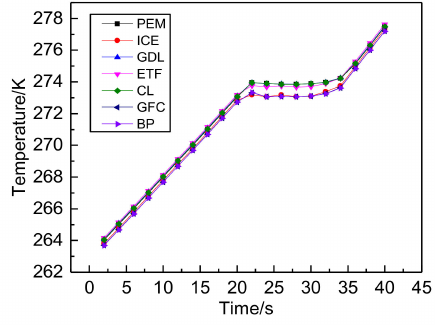
Figure 13. The average temperature distribution of each layer in the PEMFC stack.